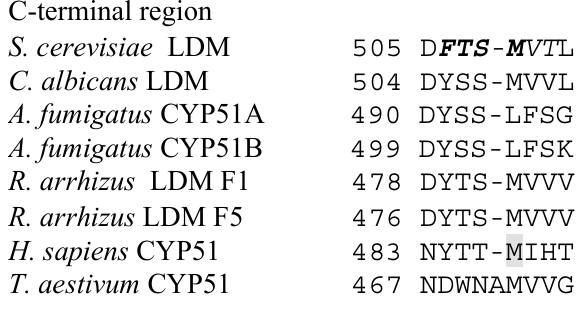
Figure 5. Comparison of itraconazole (ITC) and lanosterol binding plus residues that confer innate resistance to azole drugs in eukaryotic CYP51s. Residues within ScCYP51 LBP are highlighted in italics and those within 4 Å of ITC are highlighted in bold. Residues within 4 Å of lanosterol in the HsCYP51 D231A H314A mutant catalytic domain that has high substrate occupancy are highlighted in green. Residues with their main chain amide (M378 and I379) or main chain carbonyl (M487) involved in a water-mediated hydrogen bond network with the 3-hydroxyl of lanosterol are highlighted in gray while the residue (I379) using its main chain carbonyl to make a direct hydrogen bond with lanosterol is highlighted in gray and in bold. Residues where alignments and experimental work indicate possible roles in substrate specificity and/or causes of innate resistance to azole drugs are highlighted in light blue. Selected residues identified as relevant to innate azole resistance representative of molds are illustrated using A. fumigatus and for mucormycetes they are illustrated using R. arrhizus